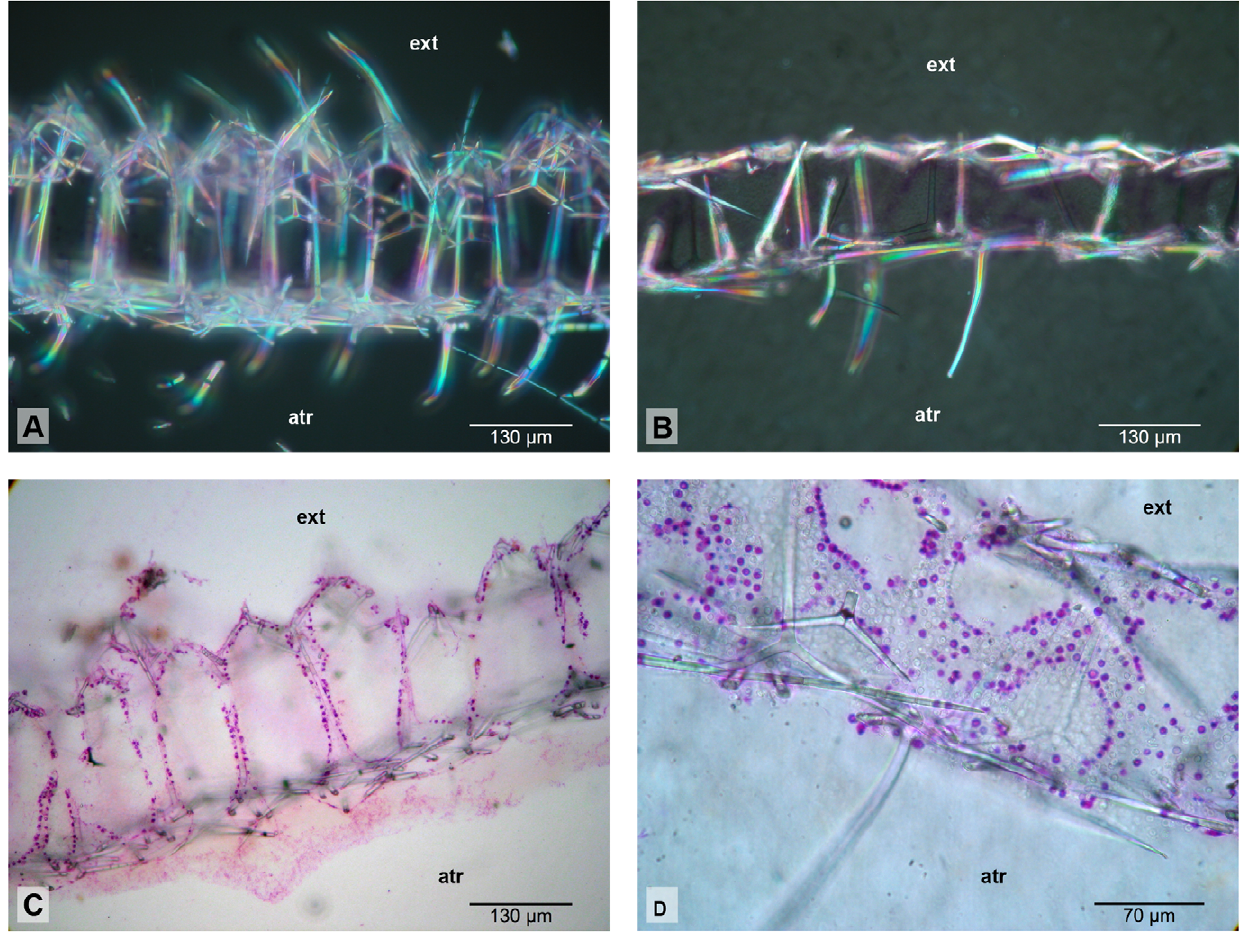
Figure 7. Comparison of Syconcarteri (A,C) and Leucascandracaveolata (QM G316146) (B,D). A, B: Skeletal arrangement; the atrial skeleton at the lower side, the distal cones or the cortical skeleton respectively on top, C,D: syconoid and alveolar leuconoid aquiferous system.